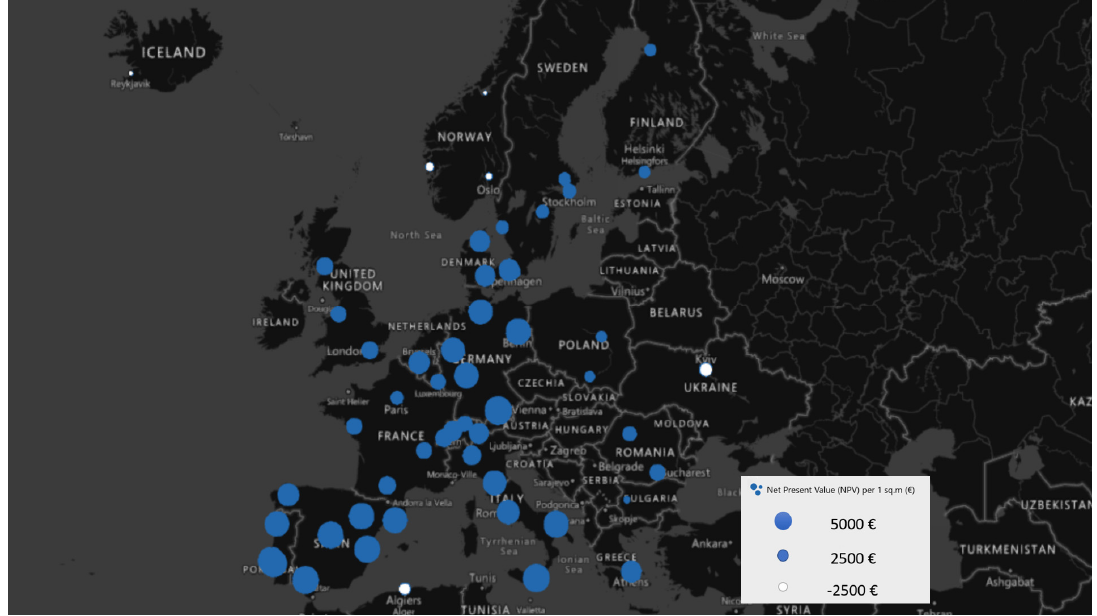
Figure 24. NPV potential per unit collector area in Europe for financing model 2.